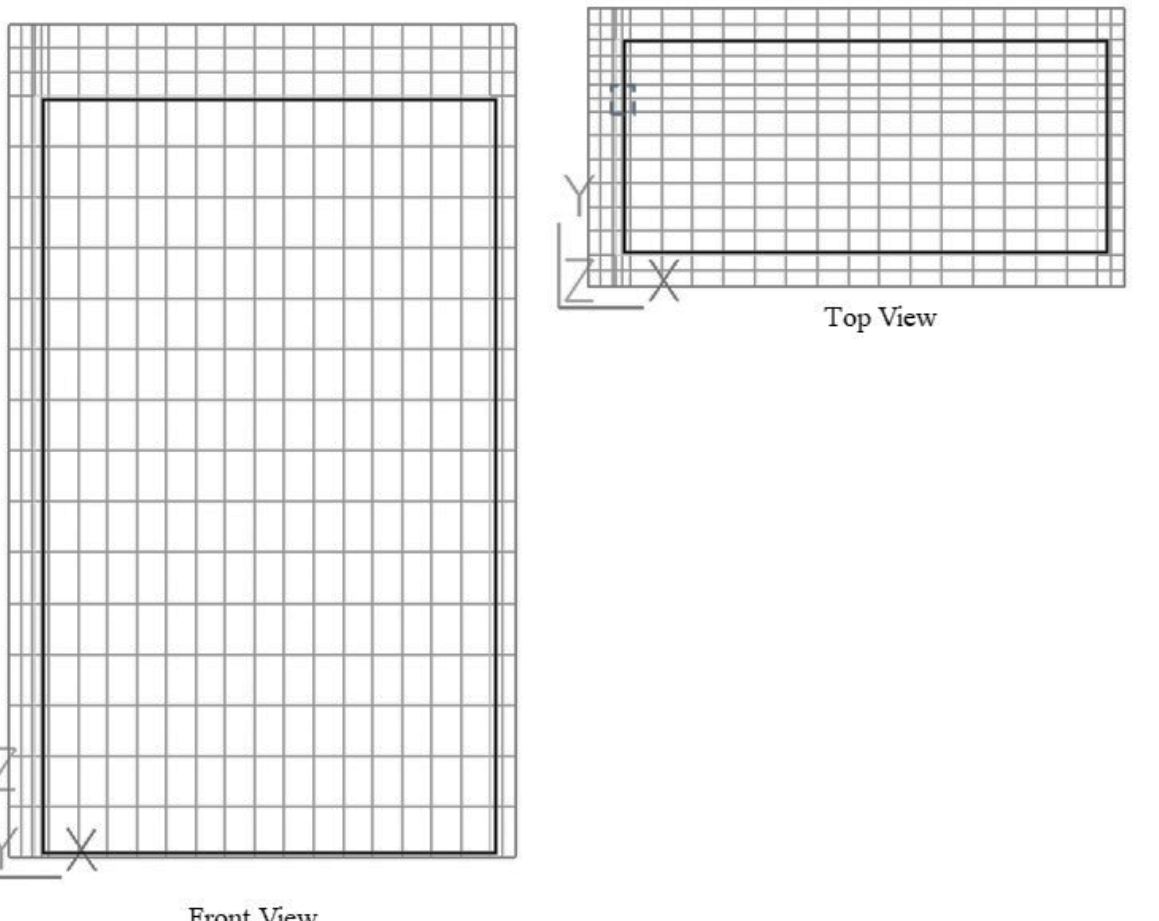
Table 1. Computational conditions used for the chamber